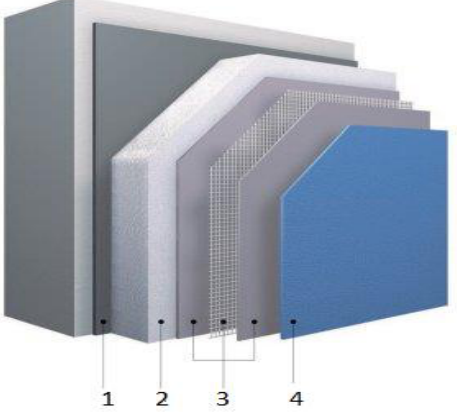
Figure 1. External thermal insulation composite systems (ETICS) components: 1—adhesive, 2—thermal insulation material (it can be fixed with mechanical connectors-pins), 3—reinforcement (mortar + glass fiber mesh), 4—finishing coat.